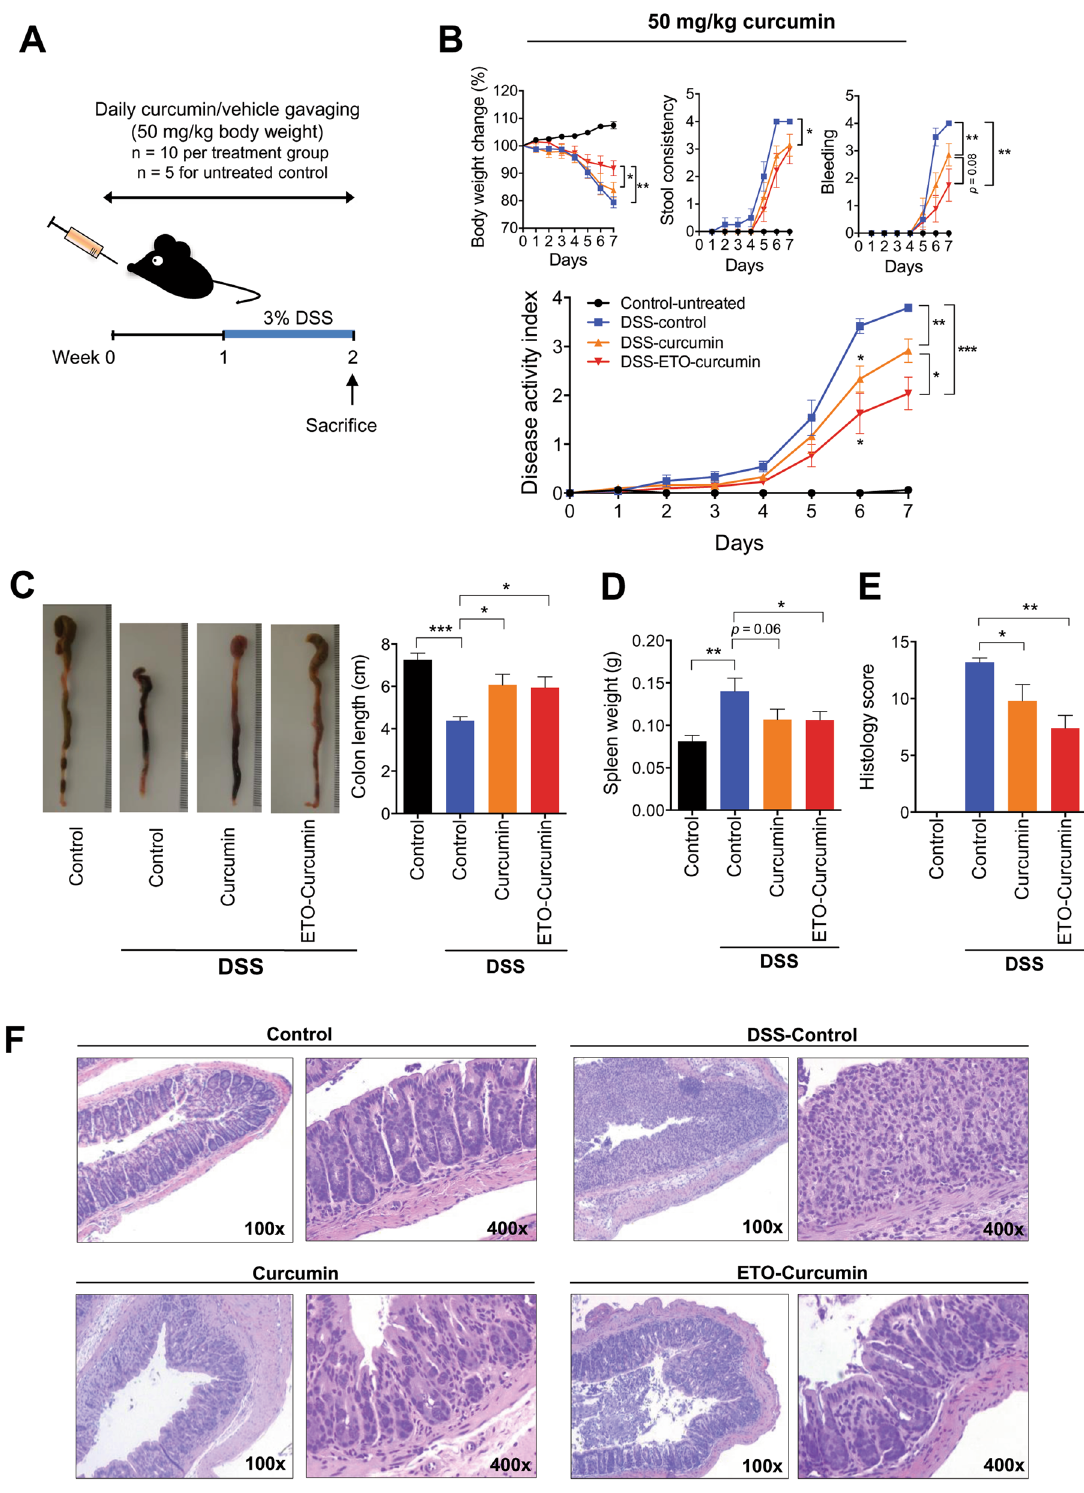
Figure 2. ETO-curcumin exerts superior anti-inflammatory effects compared to standard curcumin on DSS-induced inflammation at 50 mg/kg body weight. ( A ) Graphical representation of curcumin treatment strategy. ( B ) Changes in individual categories of disease activity index (DAI) (top), body weight changes, stool consistency and stool bleeding (left-right). Changes in DAI (bottom). ( C ) Representative image of colons (left) and average colon length (right). ( D ) Spleen weight and ( E ) Histology score on day 14. ( F ) Representative haematoxylin and easin (H&E) staining of large intestine on day 14. 100x magnification (left) and 400x magnification (right). * p < 0.05, ** p < 0.01, *** p <